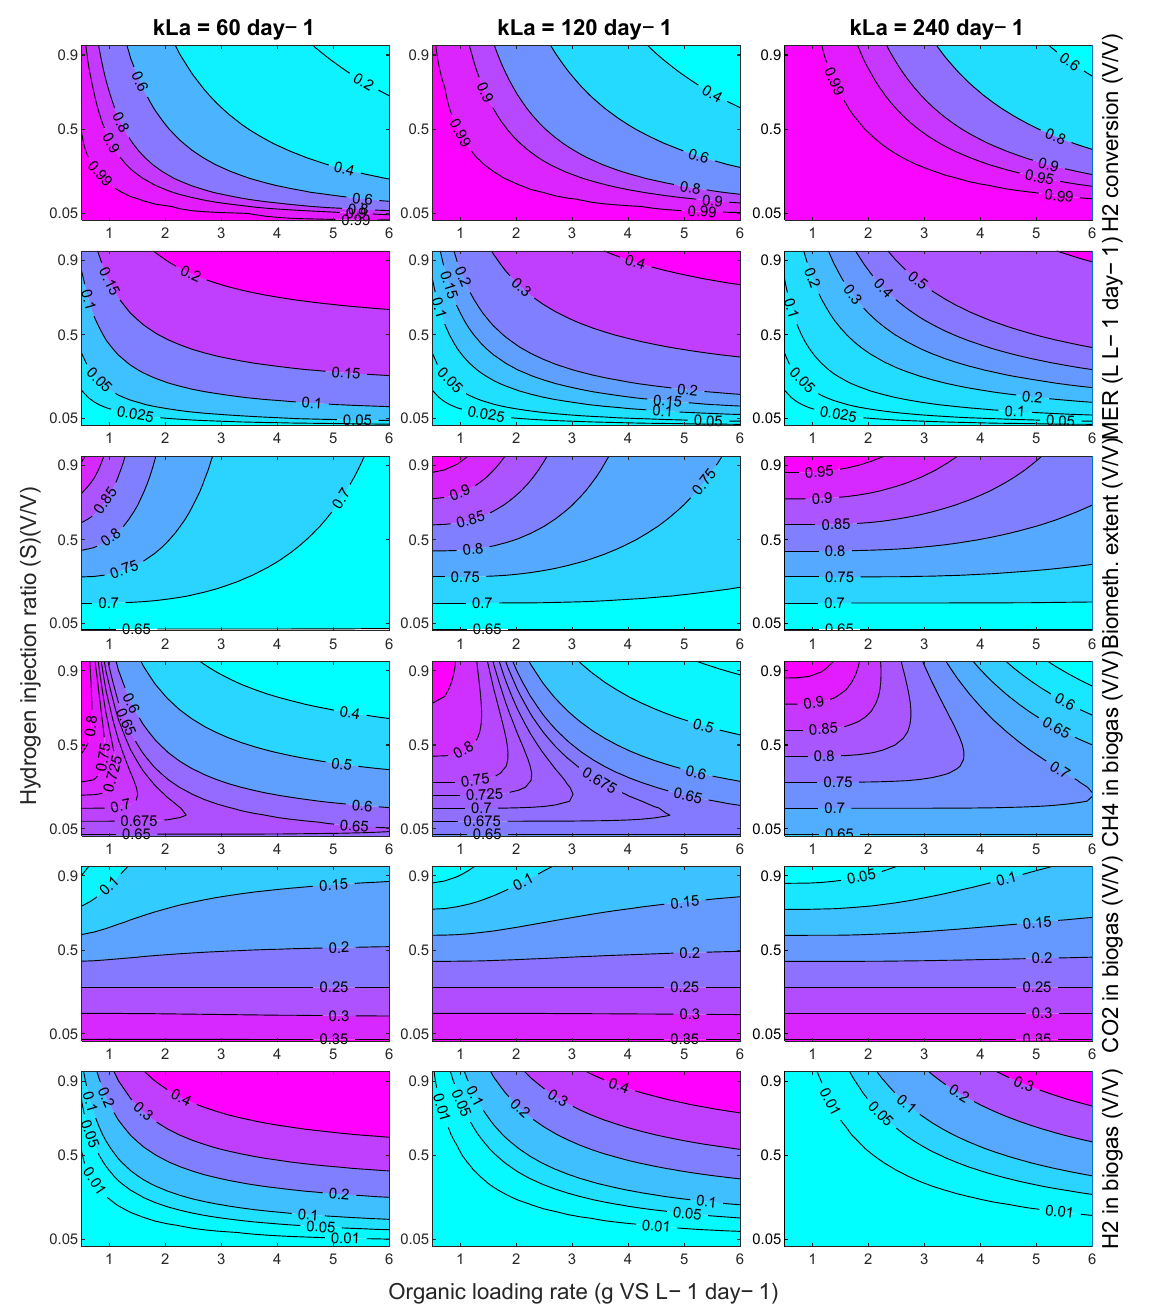
Figure A1. Contour plots of modelled in-situ biomethanation performance using FW with a variation in the OLR and hydrogen injection ratio for k L a of 60, 120, and 240 day − 1 .